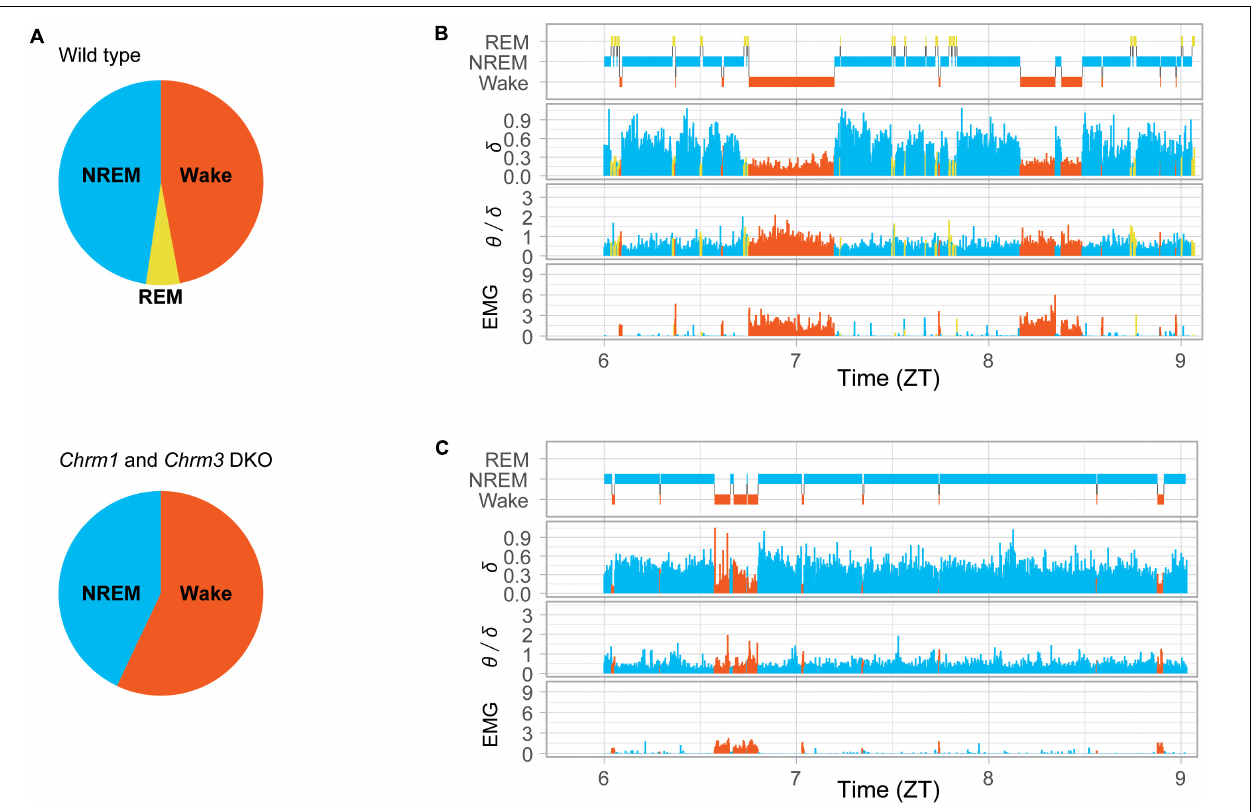
FIGURE 4 | Power of EEG theta and delta oscillations in Chrm1 and Chrm3 DKO mice. (A) Pie charts presenting the proportions of sleep stages detected in wild-type mice (top) and double knockout (DKO) mice (bottom). REM sleep in wild-type mice was 72 min a day while almost undetected in DKO mice. (B) Hypnogram of a wild-type mouse. Delta power (normalized mV 2 ), the ratio of theta/delta power, and total power of EMG signal. (C) Hypnogram of a Chrm1 and Chrm3 DKO mice. Orange for wakefulness, yellow for REM, and blue for NREM are shown. The enrichment of theta oscillation (increase in the value of θ / δ ), that is associated with REM sleep in (A) , was hardly detected during sleep in the DKO mice (C) . The plots were reproduced from the data published in the literature (Niwa et al.,